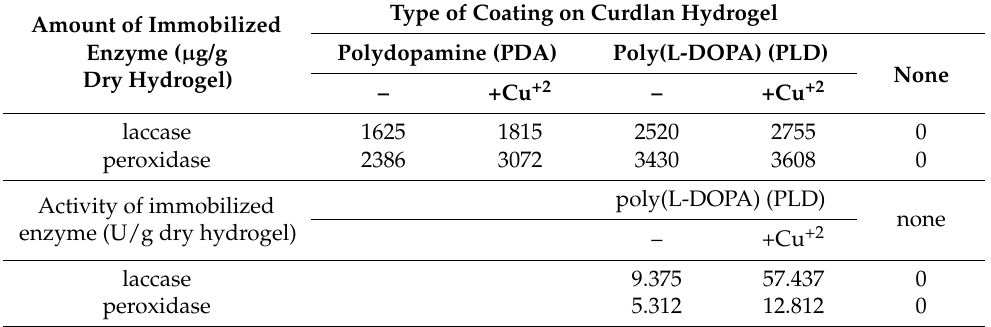
Results of laccase and peroxidase immobilization on polycatecholamine-coated curdlan